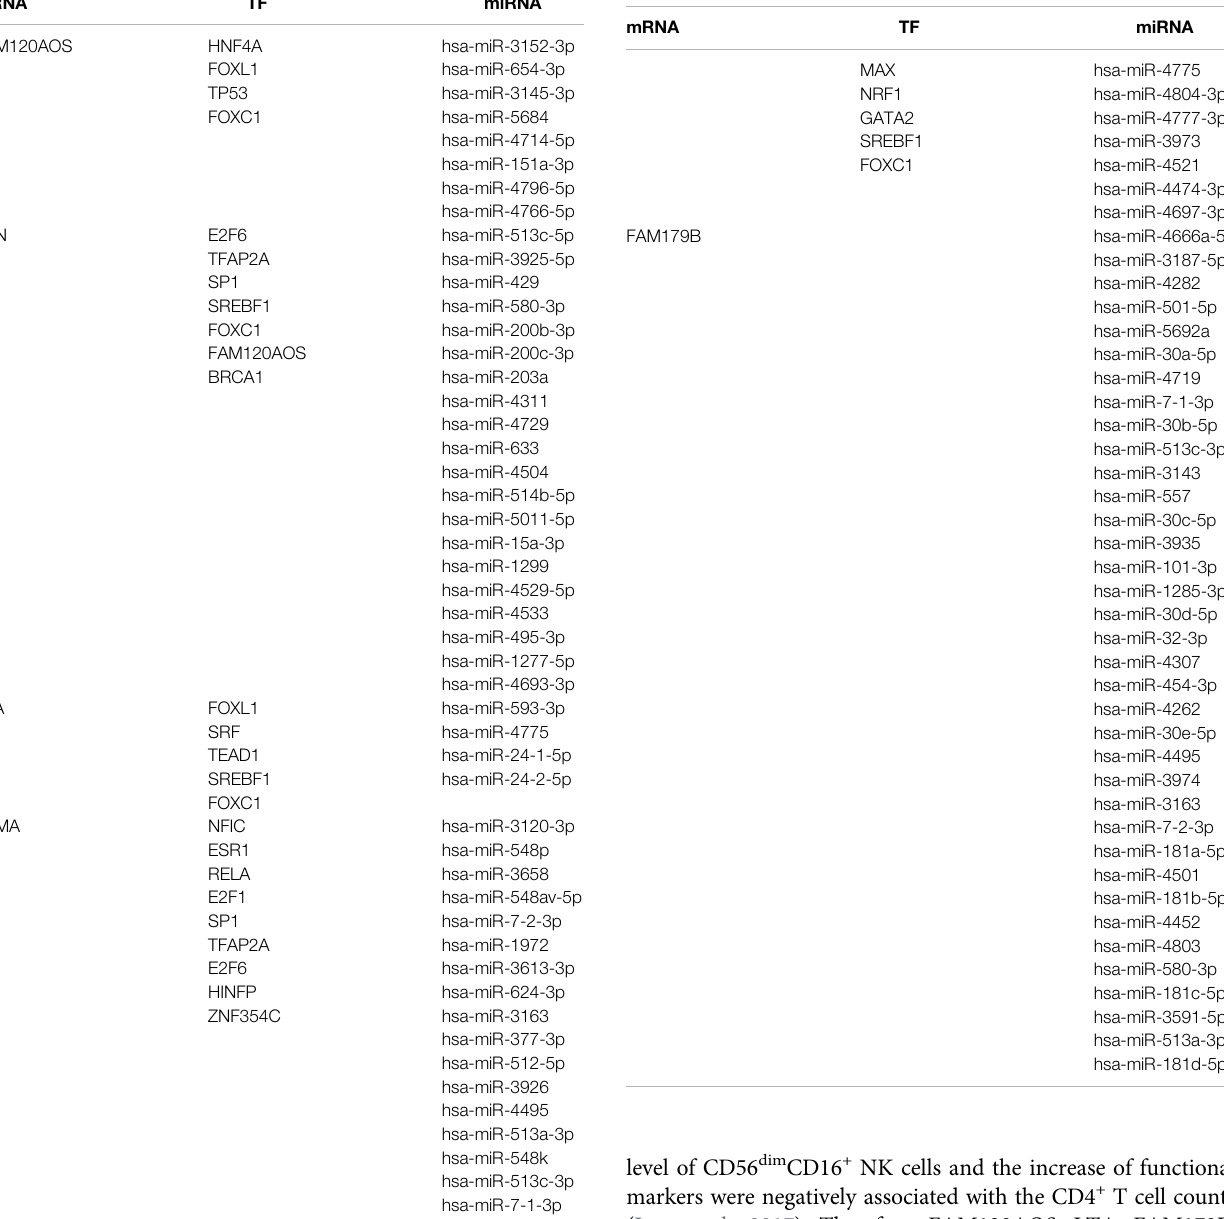
TABLE 2 | The relationship in the miRNA-mRNA-TF regulatory network. mRNA